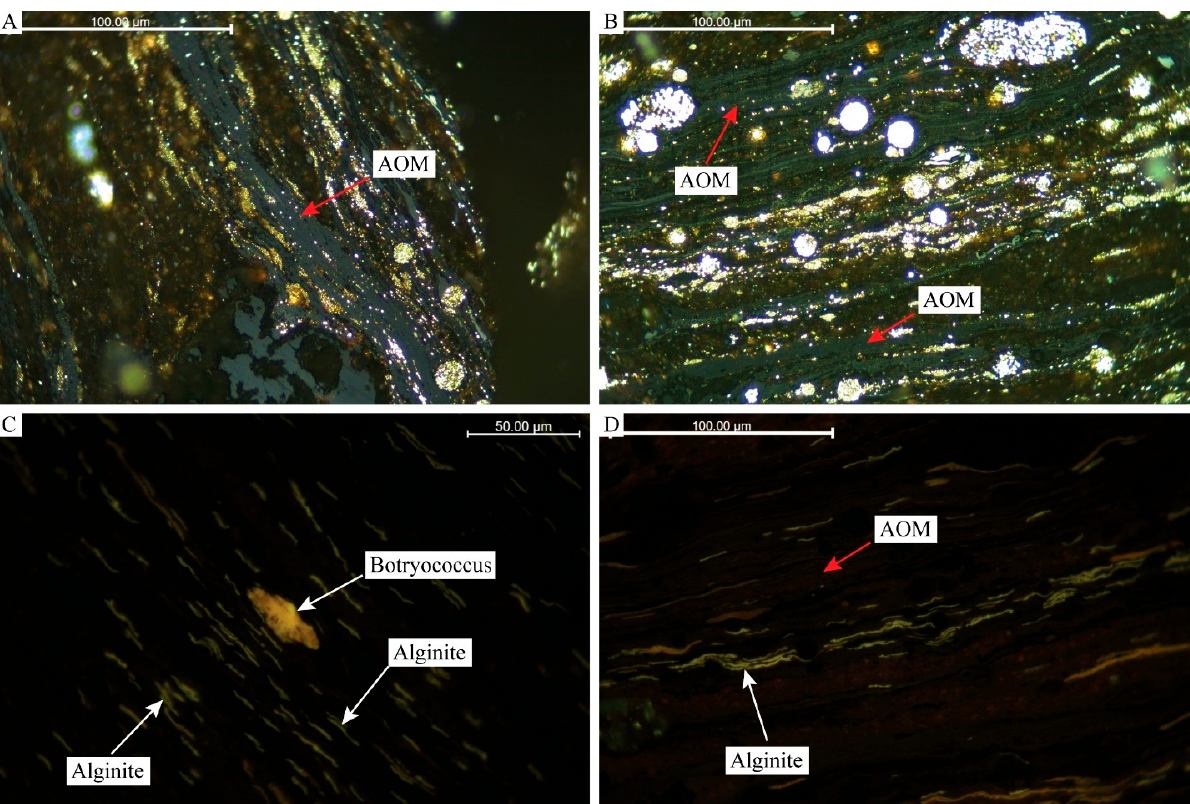
Figure 4. Photomicrographs of macerals in reflected white light and oil immersion ( A , B , E – H ) and in fluorescence mode ( C , D ) in the studied Chang 7 Member shale samples. ( A , B ) Amorphous or- ganic matter (AOM). Note that AOM is mixed with fine mineral particles, especially pyrite. ( A ) Sample KQ-4. ( B ) Sample KQ-5. ( C , D ) Alginite. ( C ) A Botryococcus in the center. Abundant greenish yellow fluorescing algal bodies parallel to bedding. Sample KQ-2. ( D ) Intercalated greenish yellow